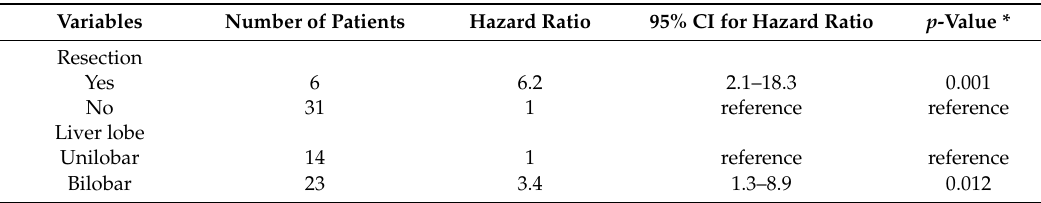
Table 7. Independent Variables with a significant influence on overall